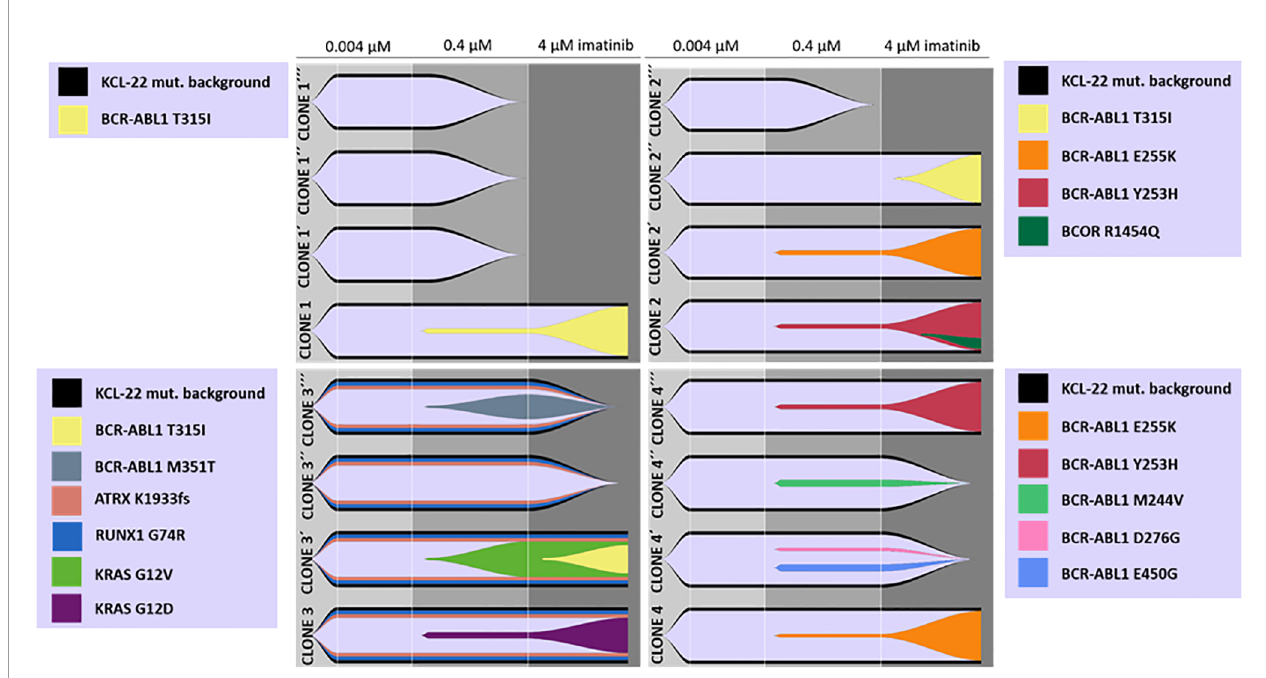
FIGURE 2 | De novo acquisition and evolution of somatic mutations during the development of KCL-22 clones resistant to 4 µM imatinib. Originally, 4 single-cell FACS-resistant CD38- clones, Clone 1, Clone 2, Clone 3 and Clone 4, represented by the lower fi sh plots in each quadrant, were isolated by a stepwise increase in imatinib concentration and analyzed for mutations by a DNA NGS custom panel. The cells of each clone (using cryopreserved samples from day 21 after sorting) were used to repeat resistance development in biological triplicates, represented by ´, ´´ and ´´´ fi sh plots in each quadrat. The imatinib concentration was gradually increased up to 4 µM during repeated resistance development, performed exactly as before. DNA NGS custom panel analysis revealed newly obtained resistant clones that exhibit different spectra of acquired mutations, while some clones failed to repeatedly gain a resistant phenotype. The Fishplot package for R was used for data visualization. KCL-22 mutation background is shown elsewhere in detail ( Supplementary Table S4